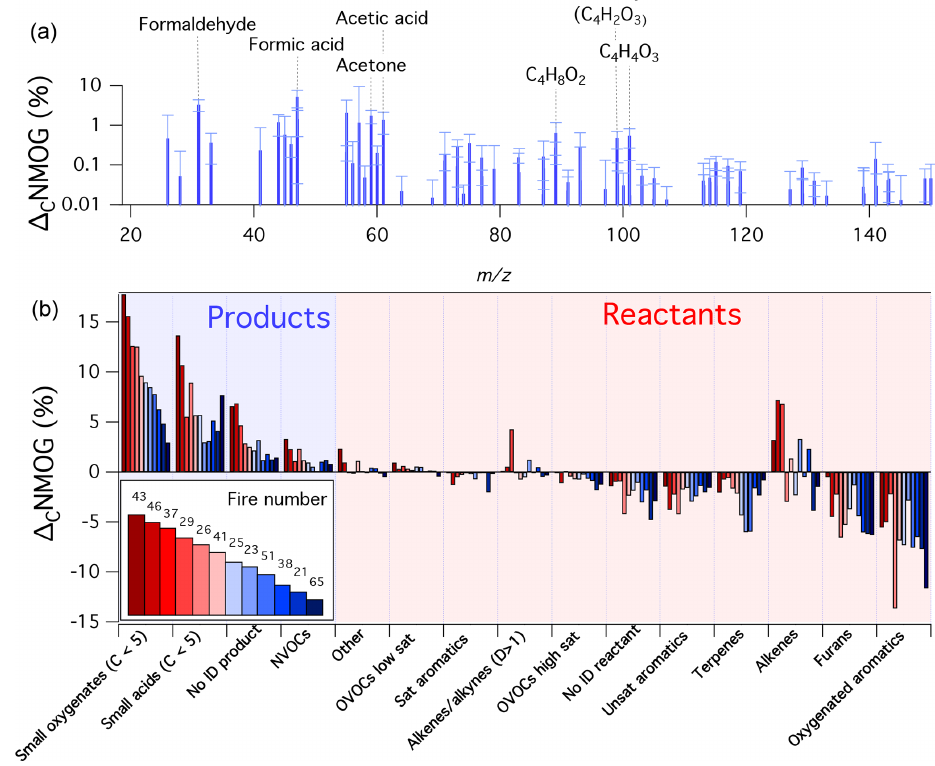
Figure 2. Summary of PTR-ToF-MS measurements during 12 mini-chamber experiments. Shown is the amount of initial NMOG carbon ( (cid:49) C NMOG, %) that was consumed (reactant) or formed (product) for a given species after 12h of atmospheric-equivalent oxidation (OH concentration of 1 . 5 × 10 6 molec.cm − 3 ). Panel (a) shows the average speciated distribution of products (error bars are standard deviations). Panel (b) shows (cid:49) C NMOG for reactants and products as lumped categories. A species is classified as a product if the dilution-corrected signal measured by the PTR-ToF-MS increased after 12h of simulated oxidation, and a reactant if the signal decreased. Categories labeled as “no ID” refer to species for which an assignment could not be confidently prescribed. The numbers in the legend refer to the fire number (composition and initial conditions can be found in Fig. S2). Experiments are ordered according to the fraction of primary carbon transformed to measurable secondary NMOGs (greatest to